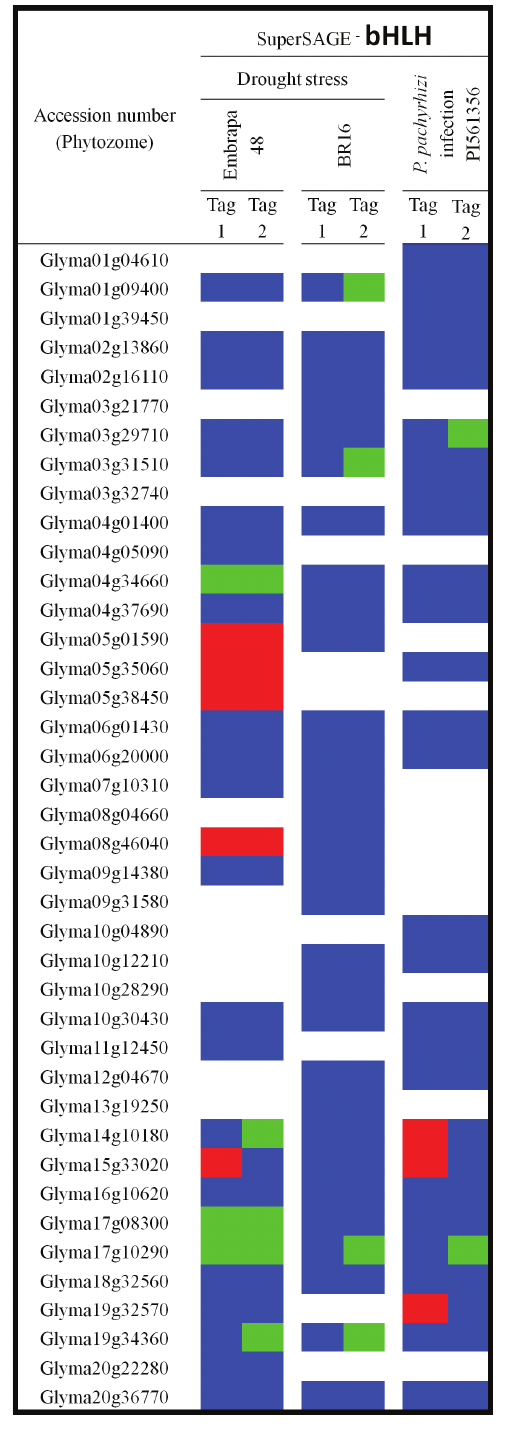
Figure 1 - Expression pattern of bHLH encoding-genes under drought stressand P.pachyrhizi infection.Theexpressiondatawereobtainedfrom superSAGE experiments available at www.lge.ibi.unicamp.br/soja/. Blocks indicate up-regulation (red), down-regulation (green), non-sig- nificant differences (p > 0.05) but expression detected (blue), and expres- sion not detected (white). Contrasting expression might reflect detection of a single gene by different tags. Drought stress was carried out in roots from Embrapa-48 (tolerant cultivar) and BR 16 (susceptible cultivar). Soybean leaves from PI561356 (resistant genotype) were infected with P. pachyrhizi